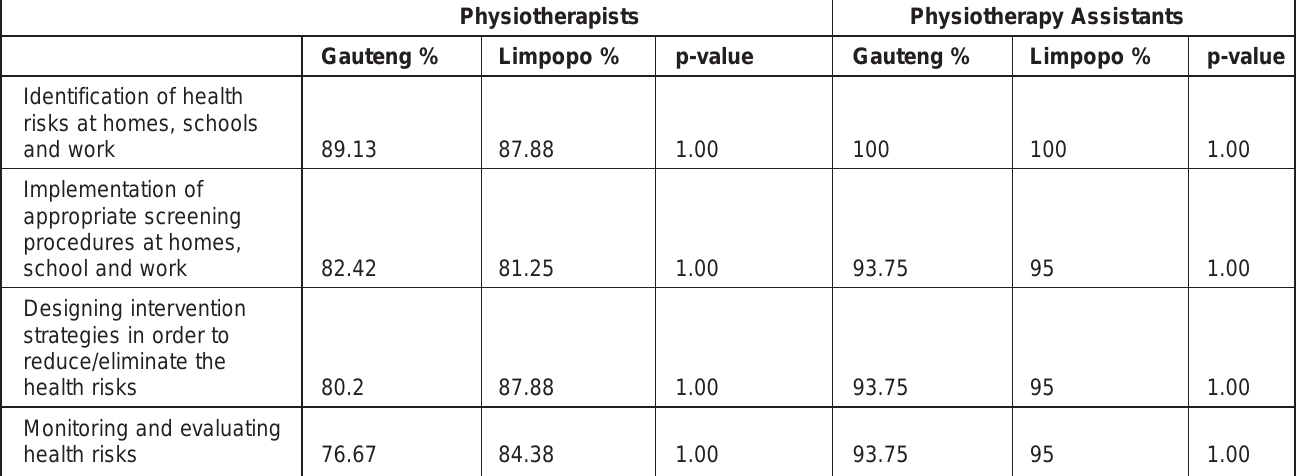
Table 4: Preventative services